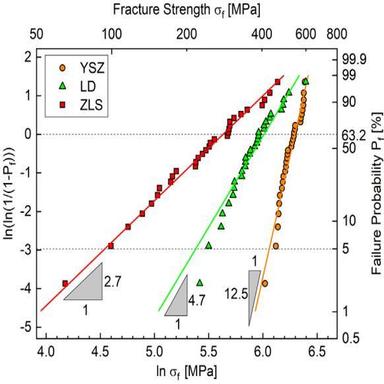
Weibull plot for the fast-fracture strength of YSZ, LD and ZLS at a stress rate 100 MPa/s.